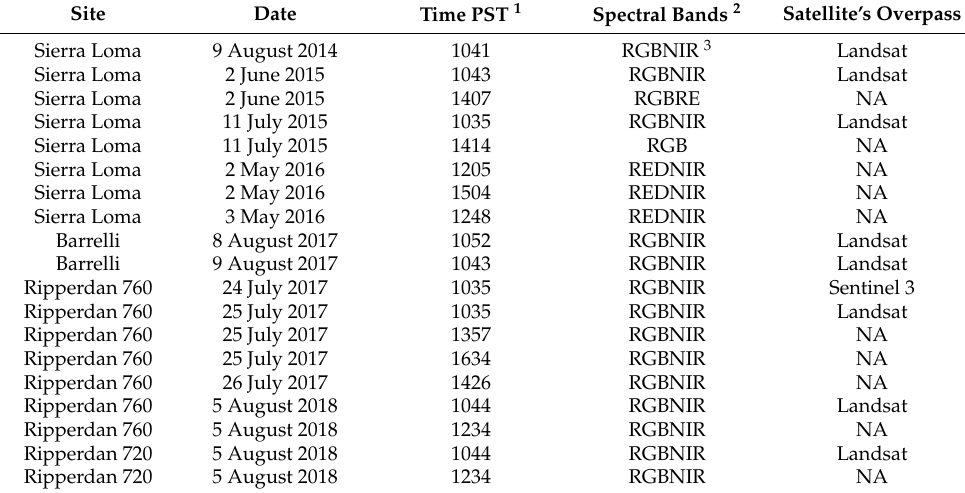
Table 1. Dates and times of AggieAir sUAS flights used in this